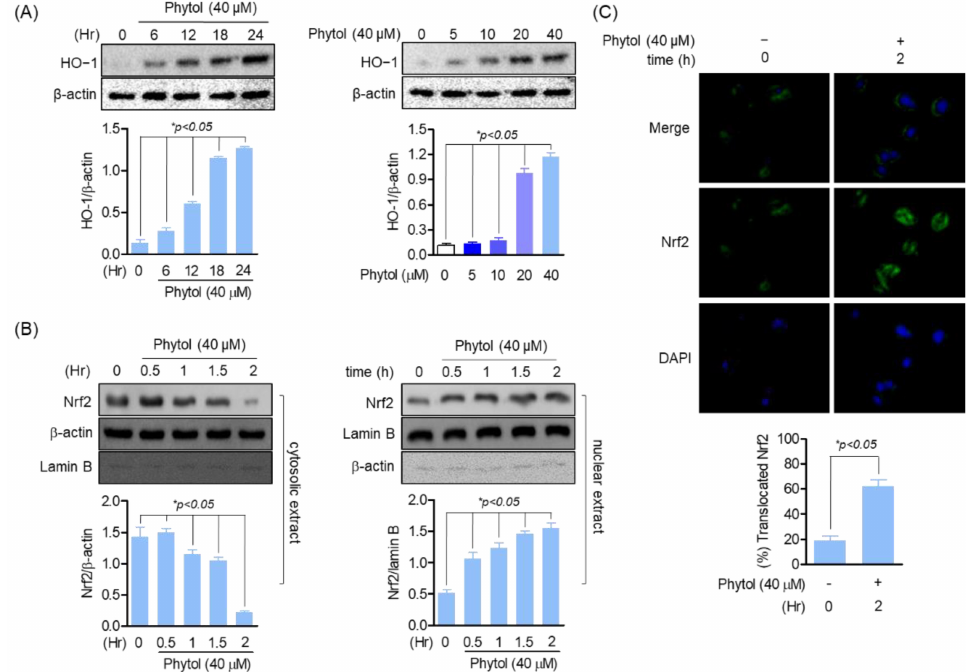
Figure 2. Phytol induces HO − 1 expression by Nrf2 translocation promotion. ( A ) Cells (1 × 10 5 cells/well) were seeded and incubated for 24 h followed by phytol treatment at the indicated concentration for Western blot detection. ( B ) Nuclear and cytoplasmic proteins were extracted according to the instruction of manufacturer (Thermo scientific, Waltham, MA, USA) before loading on sodium dodecyl sulfate polyacrylamide gels to assess the protein expression level. ( C ) After treatment with the indicated 40 µ M concentration of phytol within 2 h, Nrf2 immunocytochemistry staining was performed to confirm translocation. Data are presented as the mean of three independent experiments (Mean ±